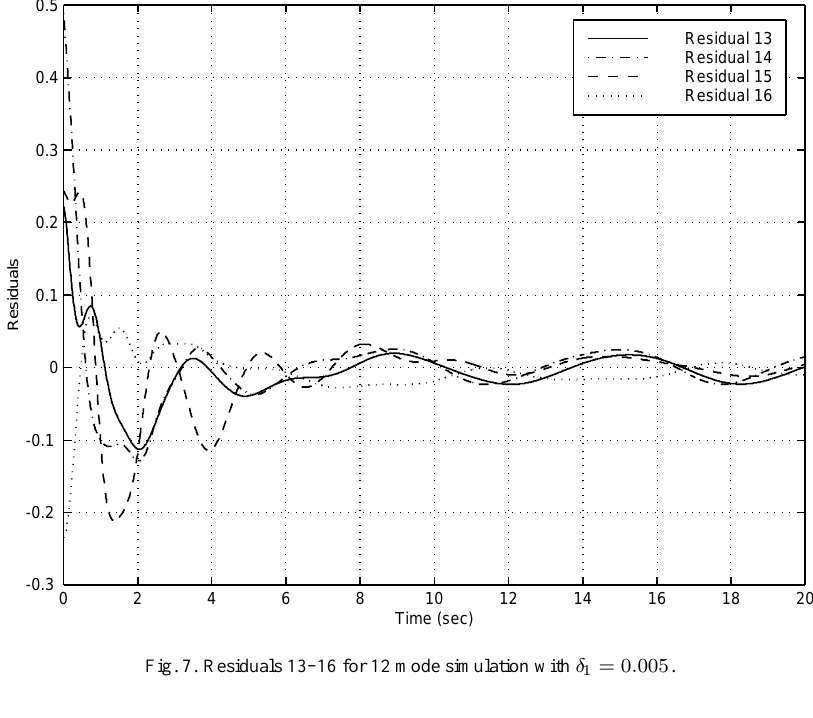
Fig. 7. Residuals 13–16 for 12 mode simulation with δ 1 = 0 . 005 .